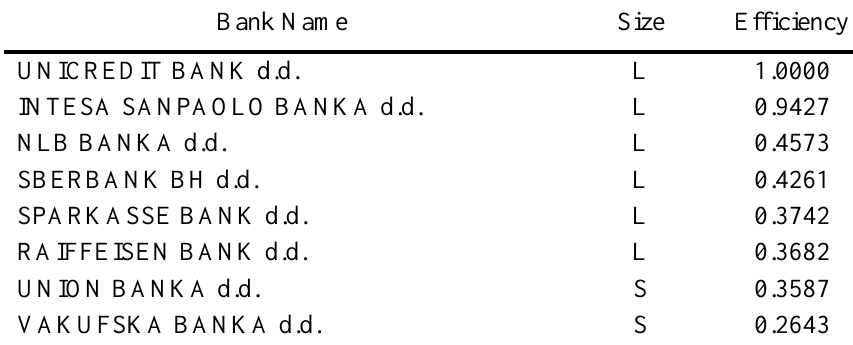
Table 3. Bank efficiency in